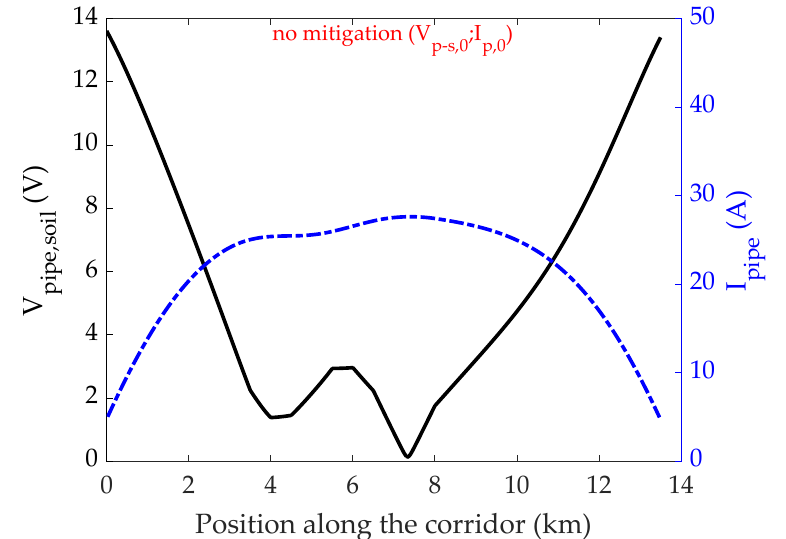
Figure 3. Magnitude of the induced pipe-to-soil voltage and longitudinal pipe current along the corridor, when no mitigations measures are put in